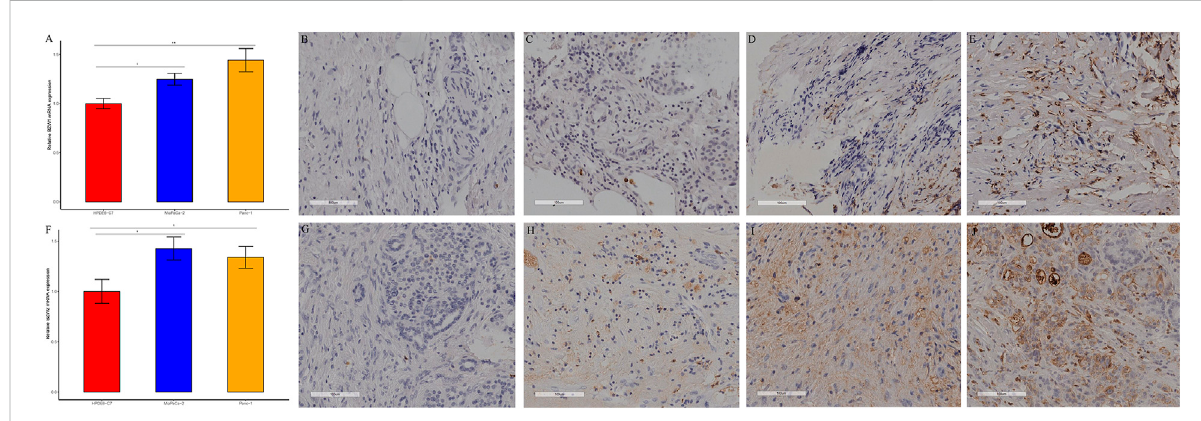
FIGURE 9 RT-qPCR and immunohistochemical staining veri fi edtheexpression of BZW1and BZW2 inPAAD samples. The relative mRNAexpression levels of (A) BZW1 and (F) BZW2 in HPDE6-C7, MiaPaCa-2 and Panc-1 cell lines. (B – E) BZW1 was mainly expressed in the cell nucleus. Stain intensity: (B) BZW1, score 0. (C) BZW1, score 1. (D) BZW1, score 2. (E) BZW1, score 3. (G – J) BZW2 mainly expressed in cytoplasm and membrane. Stain intensity: